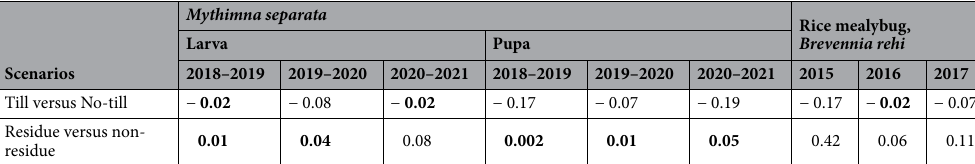
Table 2. Contrast analysis between years, crop establishment-cum-residue management and insect pest infestation. Values below 0.05 are significant and indicated in bold.